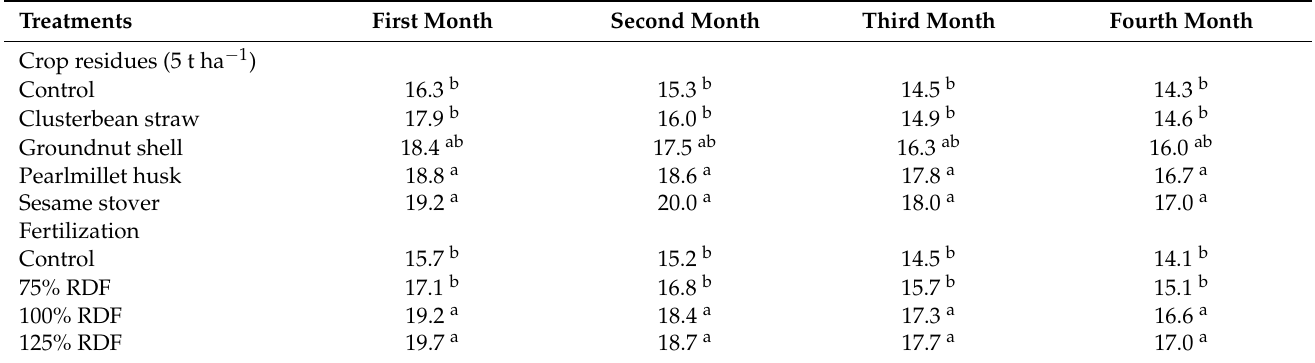
Table 2. Effect of crop residues and fertilization on dehydrogenase enzyme activity ( µ g TPF g − 1 soil 24 h − 1 ) at first, second, third, and fourth month after